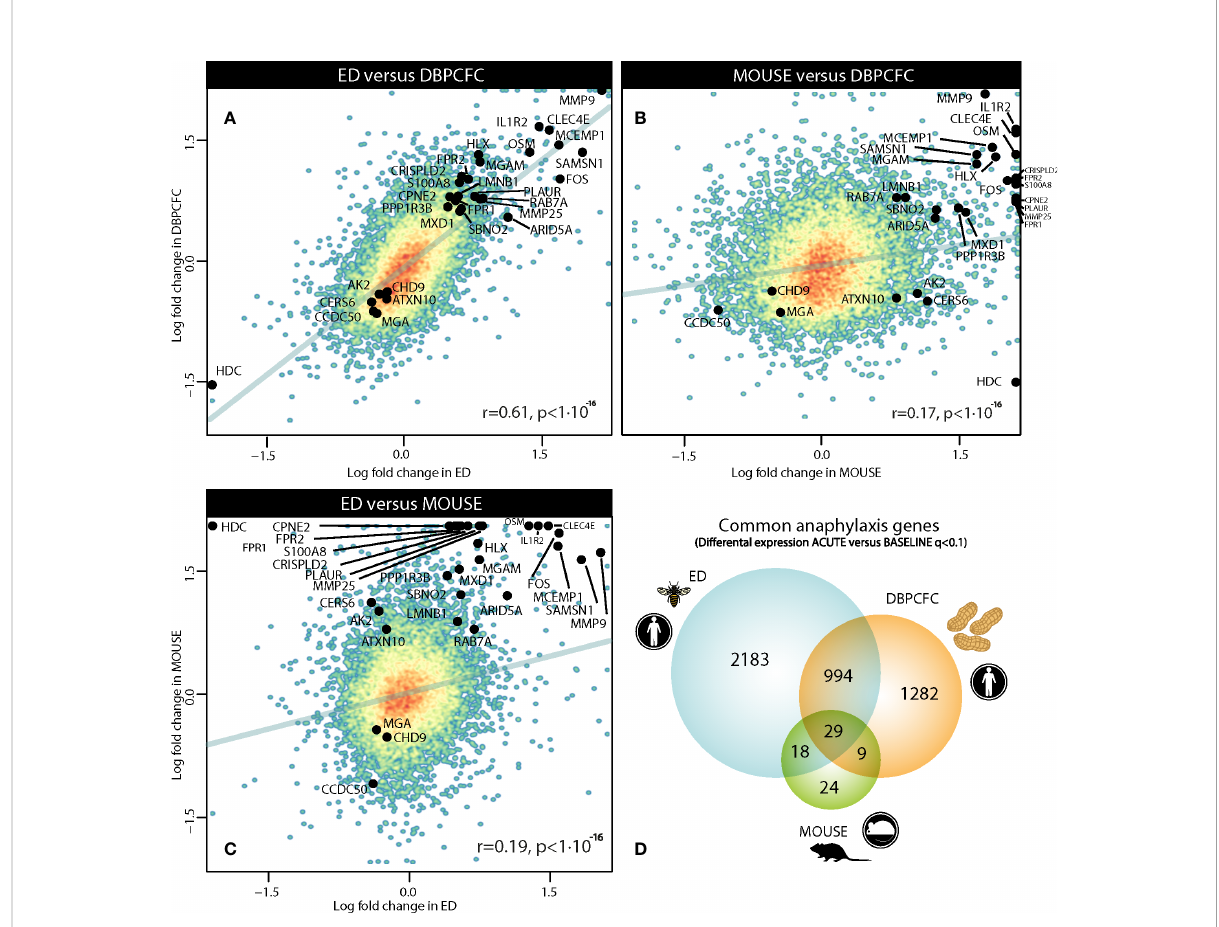
FIGURE 1 Comparison of gene dysregulation during the anaphylactic episode between human and mouse model of anaphylaxis: (A) between ED and DBPCFC study, (B) between MOUSE and DBPCFC study, and (C) between ED and MOUSE study. Overall 3224, 2314 and 80 genes were differentially expressed in ED, DBPCFC and mouse study group, respectively with (D) the overlap of 1023 DEGs for both human situations of anaphylaxis and 29 DEGs for all three study groups. Genes (n=29) differentially expressed in human and mouse model during anaphylaxis are highlighted. ACUTE, acute anaphylactic episode; ED, Emergency Department; DBPCFC, double-blind placebo-controlled food